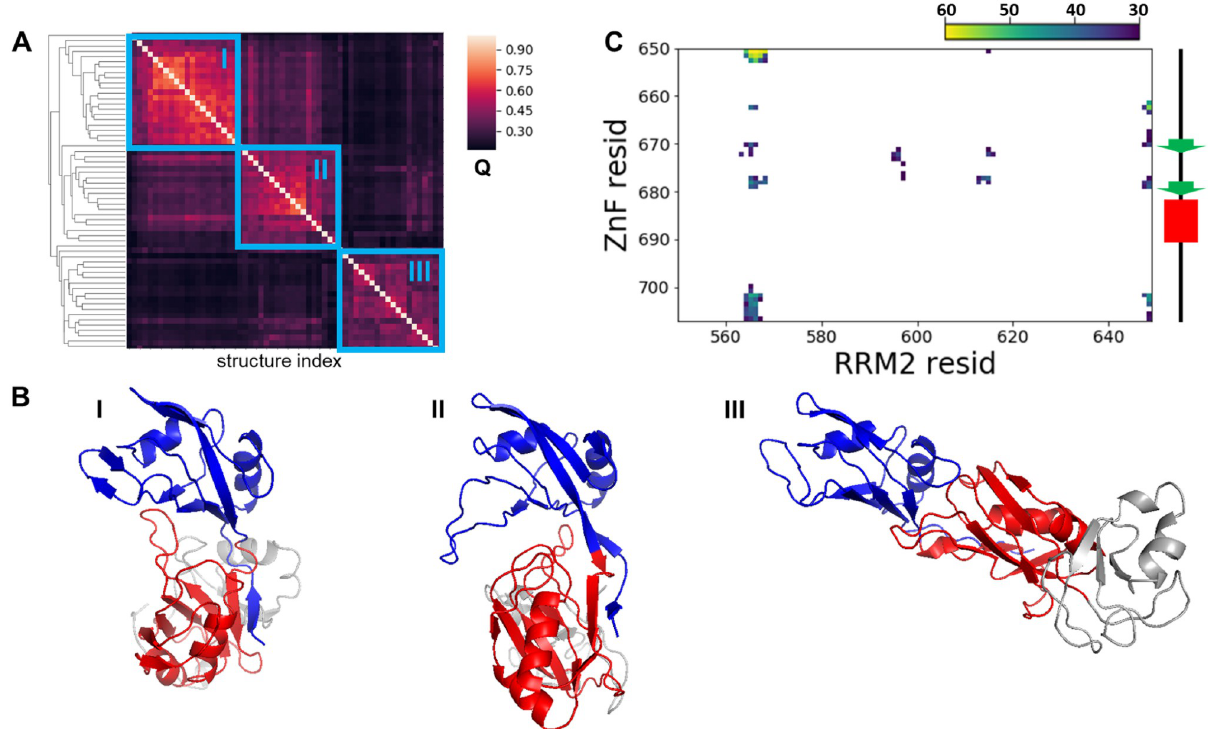
Fig 3. A . The 60 predicted structures of full length RBD that can be divided into 3 clusters using mutual Q (only including inter-domain residue pairs) as the structural similarity metric. B . Representative structures for the 3 clusters in Fig 3A. C . The frequency contact map for the inter-domain contact between the znic finger domain and the RNA recognition motif 2 (RRM2). Only contacts formed more than 30 times in 60 predictions are shown here. The diagram of the secondary structure of the ZnF domain is shown on the right side along the y-axis. Beta strands are colored in green and alpha helices are colored in